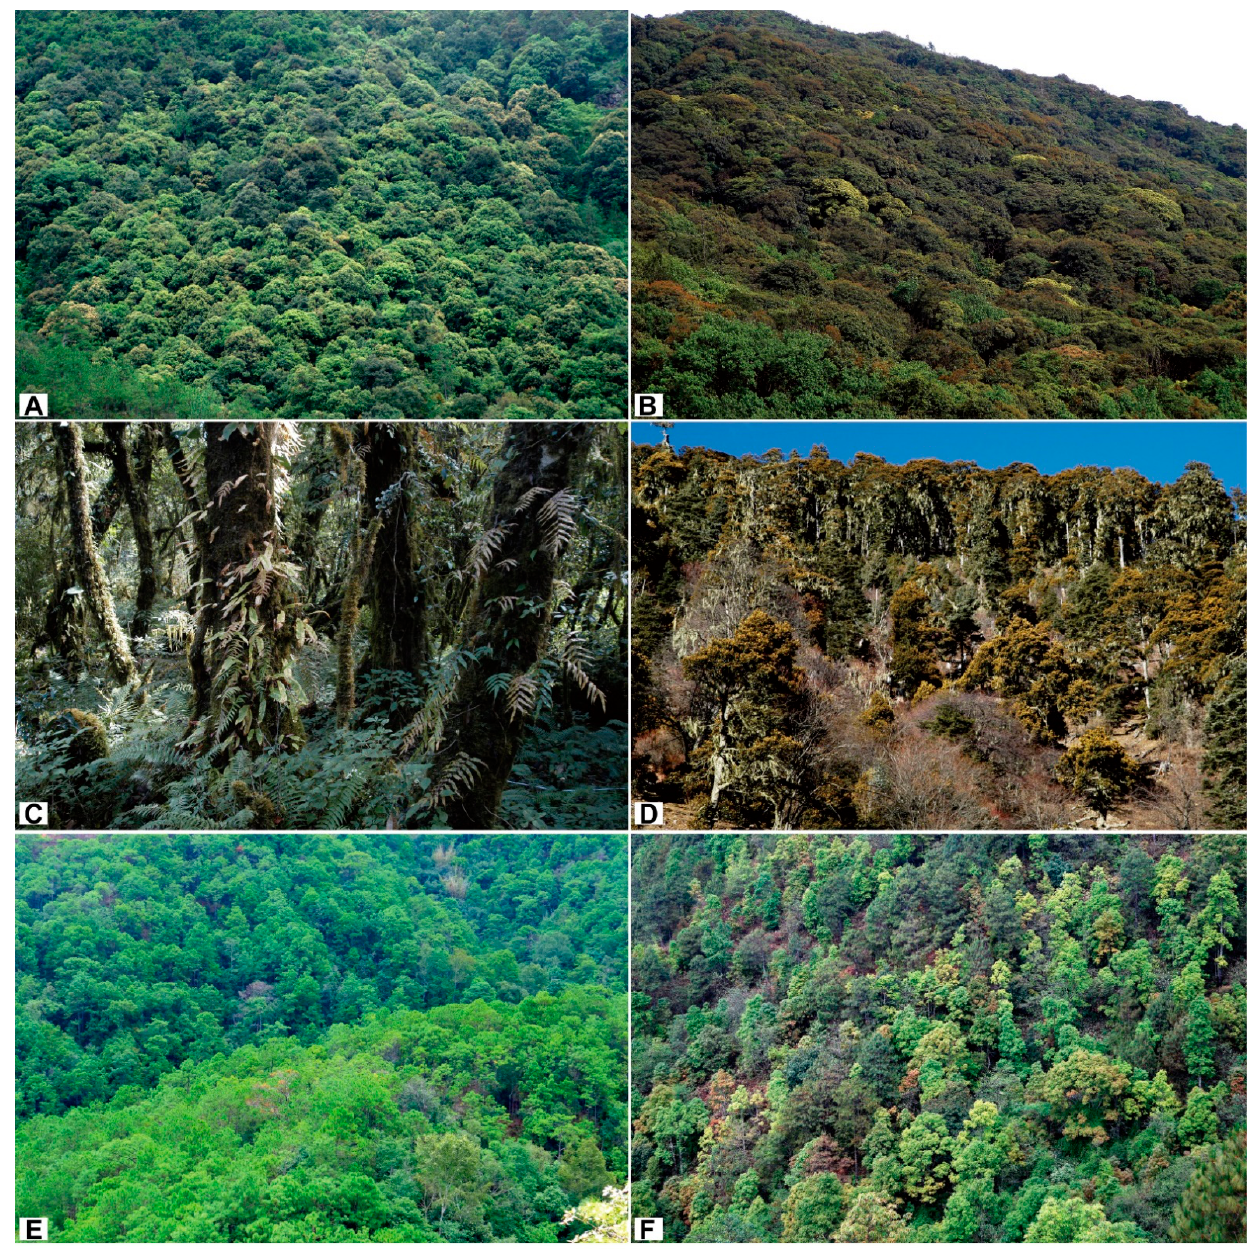
Figure 4. ( A ), Semi ‐ evergreen broad ‐ leaved forest in central Yunnan; ( B ), mid ‐ montane wet evergreen broad ‐ leaved forest in central Yunnan; ( C ), understory of the mid ‐ montane wet evergreen broad ‐ leaved forest, showing abundant epiphytes; ( D ), sclerophyllous oak forest in northern Yunnan; ( E ), temperate coniferous forest in central Yunnan; ( F ), temperate coniferous and evergreen broad ‐ leaved mixed forest in central Yunnan.